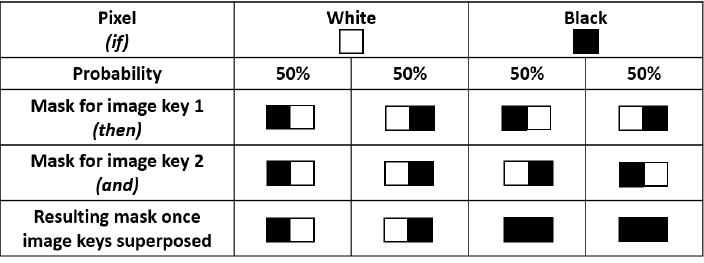
Figure 2. Principle of a pixel-based Visual Cryptography (VC) version exploiting a two-pixel binary mask